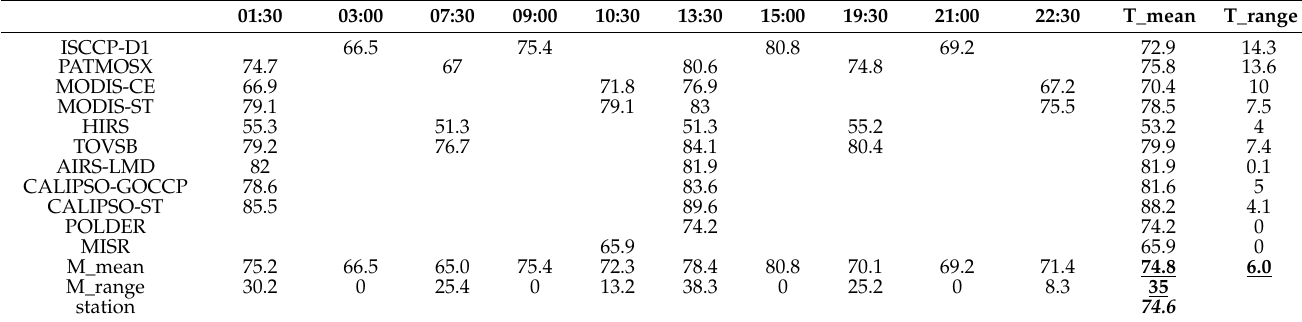
Table 2. Total cloud amount across the different observation times (local time) and different datasets in summer over south China (unit: %). M_mean is the mean cloud amount averaged over all datasets at each specific observation time; M_range is the TCA range for all satellite datasets; T_mean is the mean cloud amount averaged over all observation times for each satellite dataset; and T_range is the TCA range among different observation times. Bold value with an underscore is the mean value averaged over 11 satellite datasets at all observation times, and bold and italic value is for station observation.